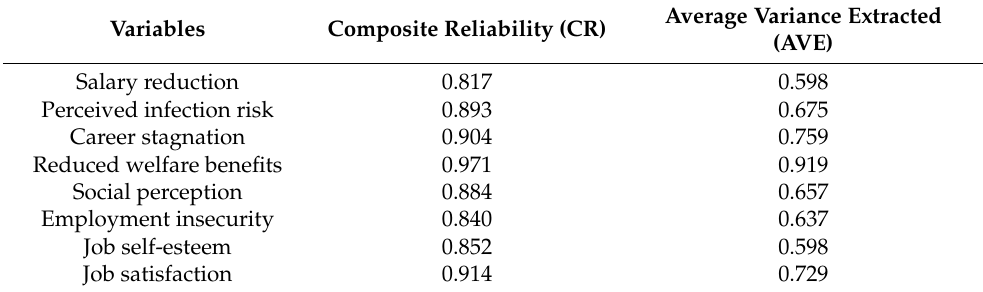
Table 3. Convergent validity analysis result.